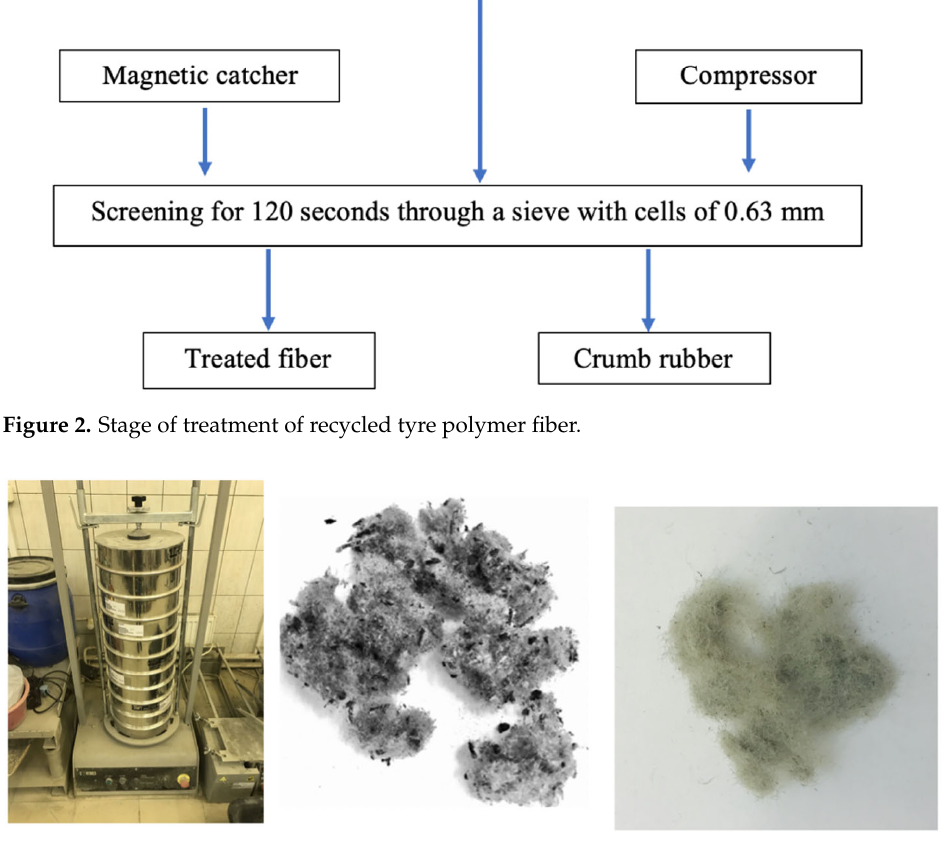
Figure 3. Treatment of recycled tyre polymer fiber: ( a ) sieve; ( b ) untreated tyre fiber; and ( c ) treated fiber.